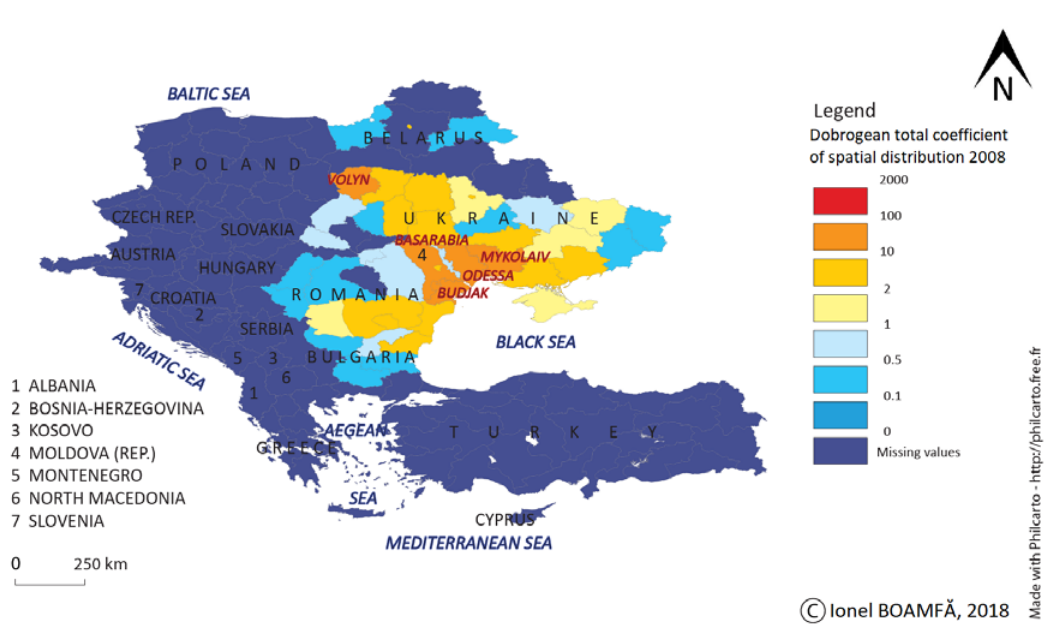
Figur e 7 . G eographical repartition of the anthroponym Dobrogean. Coef. of spatial distribution